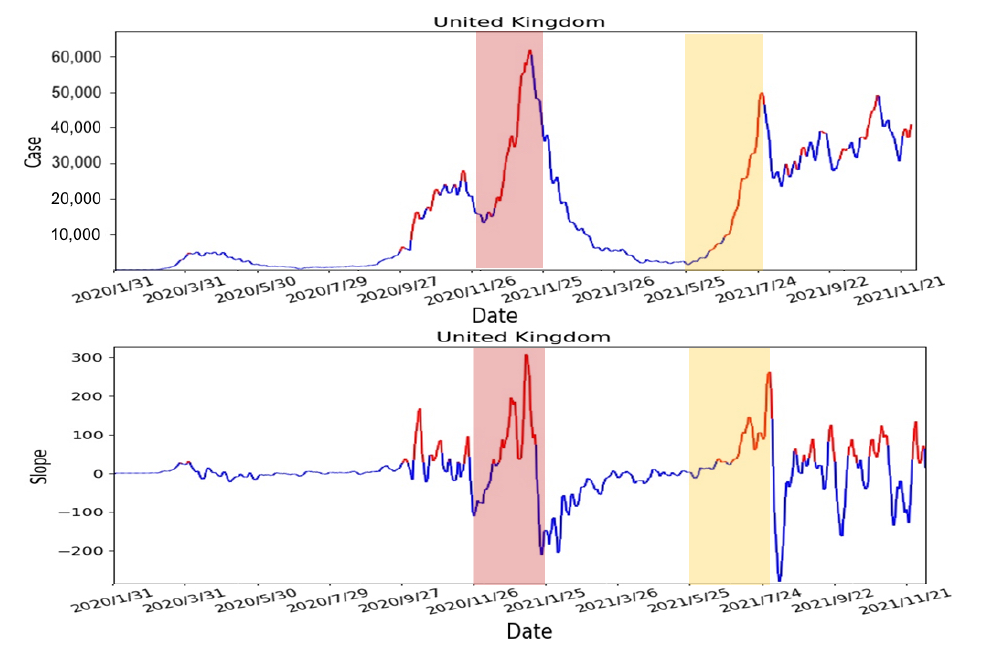
Figure 14. The result of risk analysis for the